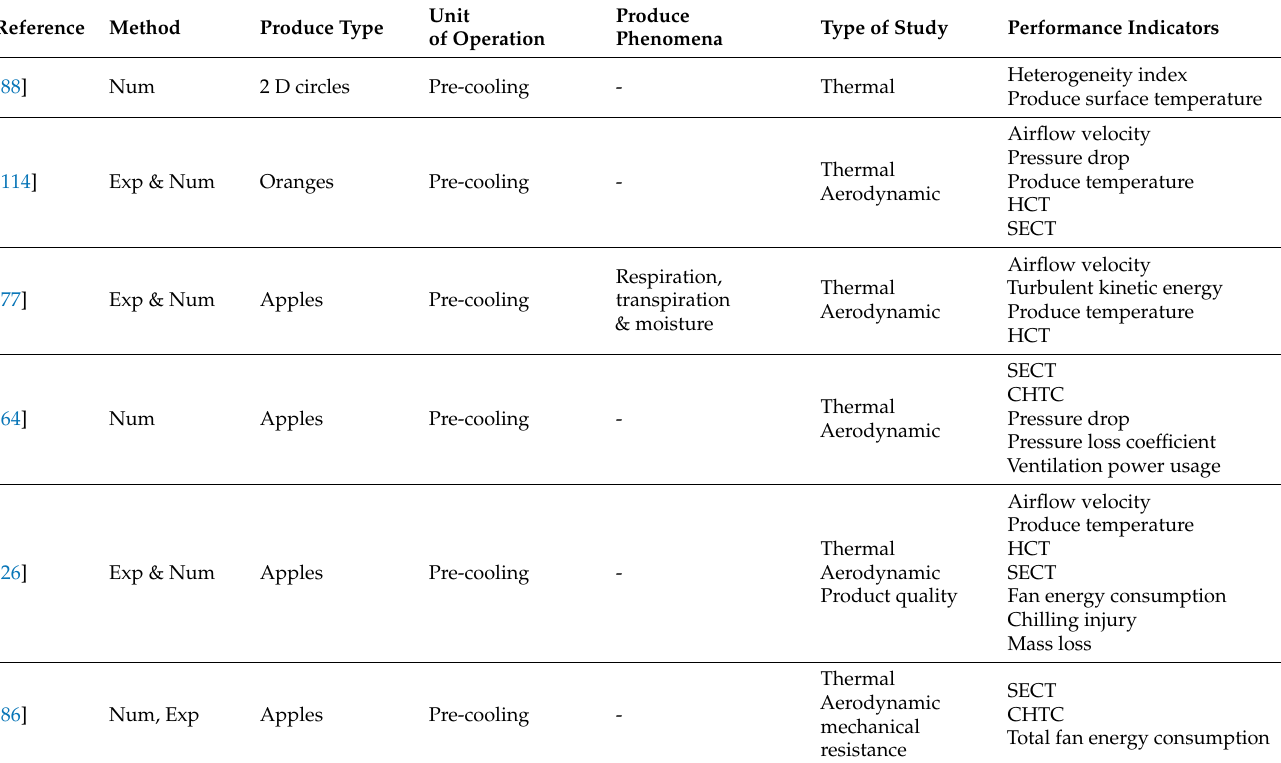
Table 7. Studies conducted to evaluate the effect of the package design on product cooling at the scale of a